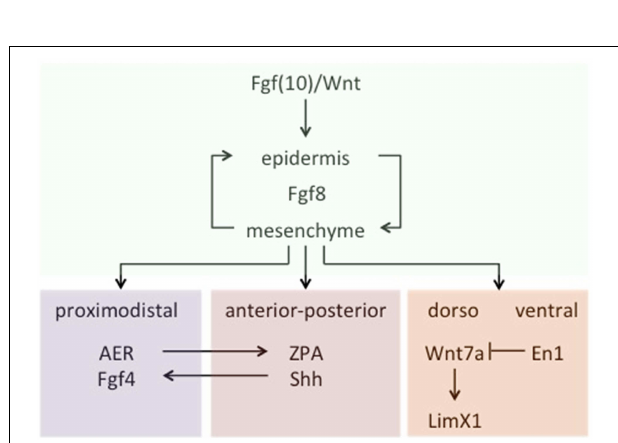
FIGURE 3 | A schematic (partial) representation of the fin/limb ChIN. Data from Wagner (2014, 341ff).